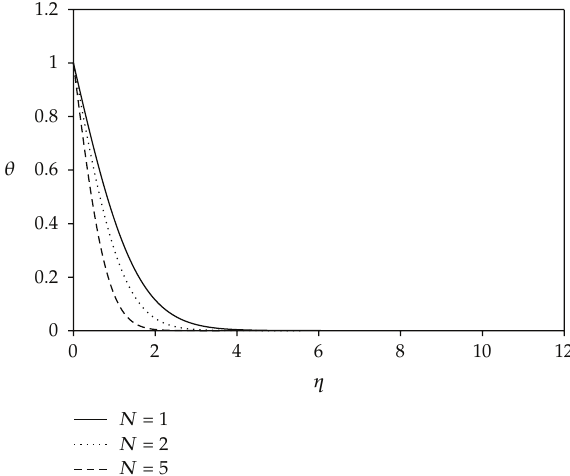
Figure 8: Temperature profile for di ff erent values of N for Du (cid:8) 0 . 03, Sr (cid:8) 2, θ r (cid:8) 5, Le (cid:8) 0 . 1, Pr (cid:8) 0 . 71, and Sc (cid:8) 0 . 1.